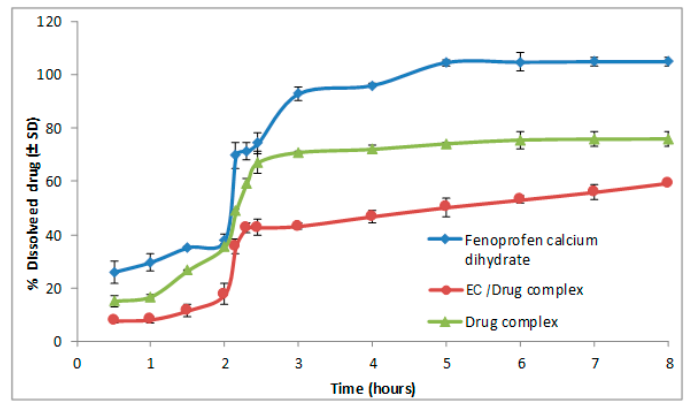
Figure 2. Effect of EC/drug complex on the dissolution of fenoprofen calcium dihydrate at pH = 1.2 for 2 h and then continued in pH = 6.8 for 6 h.